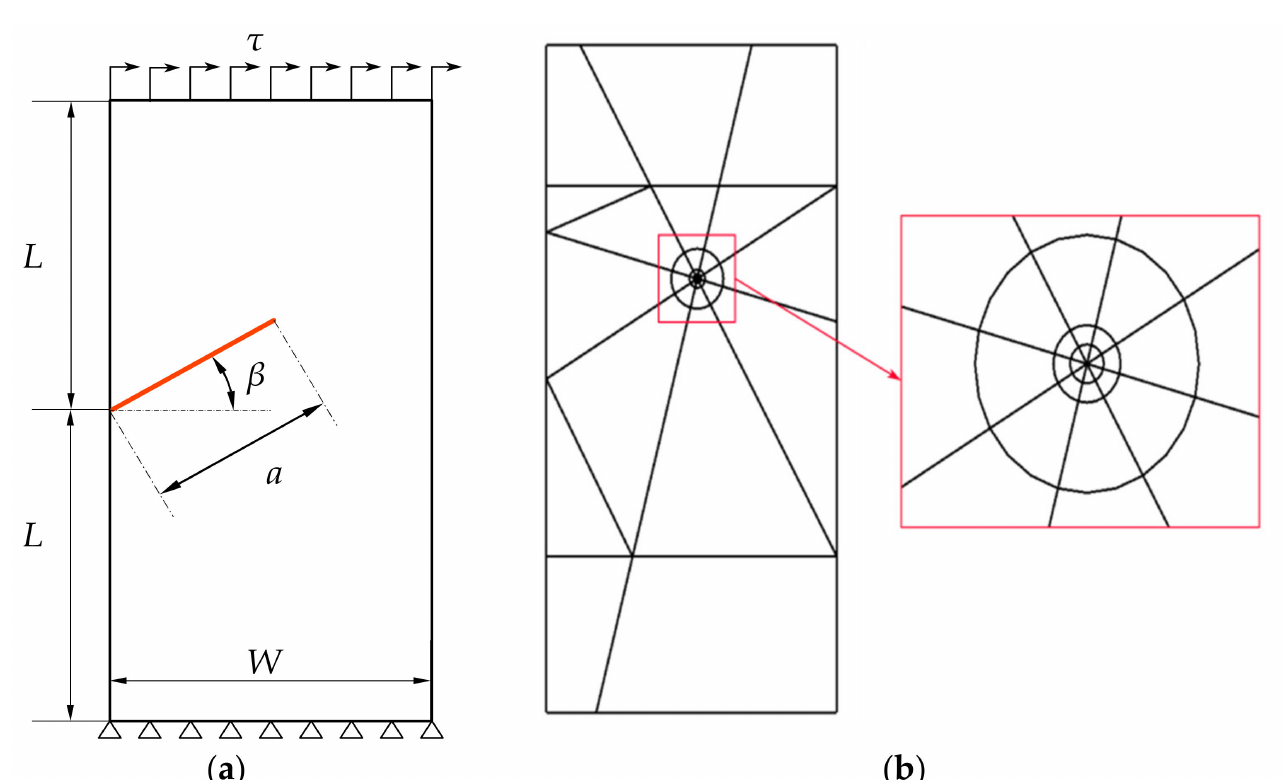
Figure 4. ( a ) A slanted single-edge cracked plate under end shearing; ( b ) Global and local meshes (the total number of elements is 39).